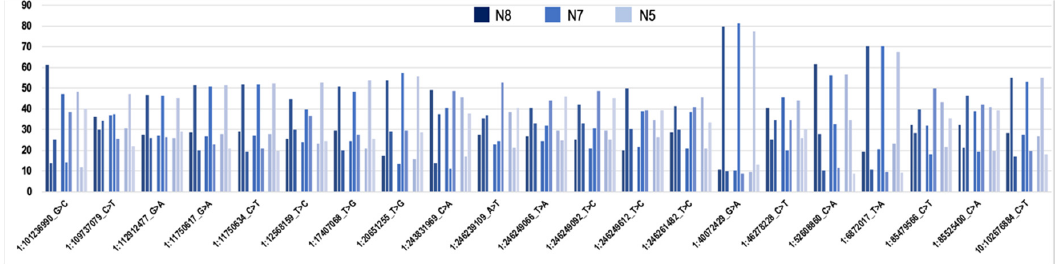
Figure 7. Percentage of cells (y-axis) displaying VAF RNA < 0.2 (for each cluster of three, left), VAF RNA between 0.2 and 0.8 (middle), and VAF RNA > 0.8 (right); minR = 10. High concordance between the three donors is seen; SNVs on chromosome 1 are shown, and the results were similar genome-wide. same gene. To do this, we pooled the SNVs from the three donors together and selected genes with more than three SNVs, each assessed from a minimum of 50 cells per donor; 3922 SNVs in 815 genes